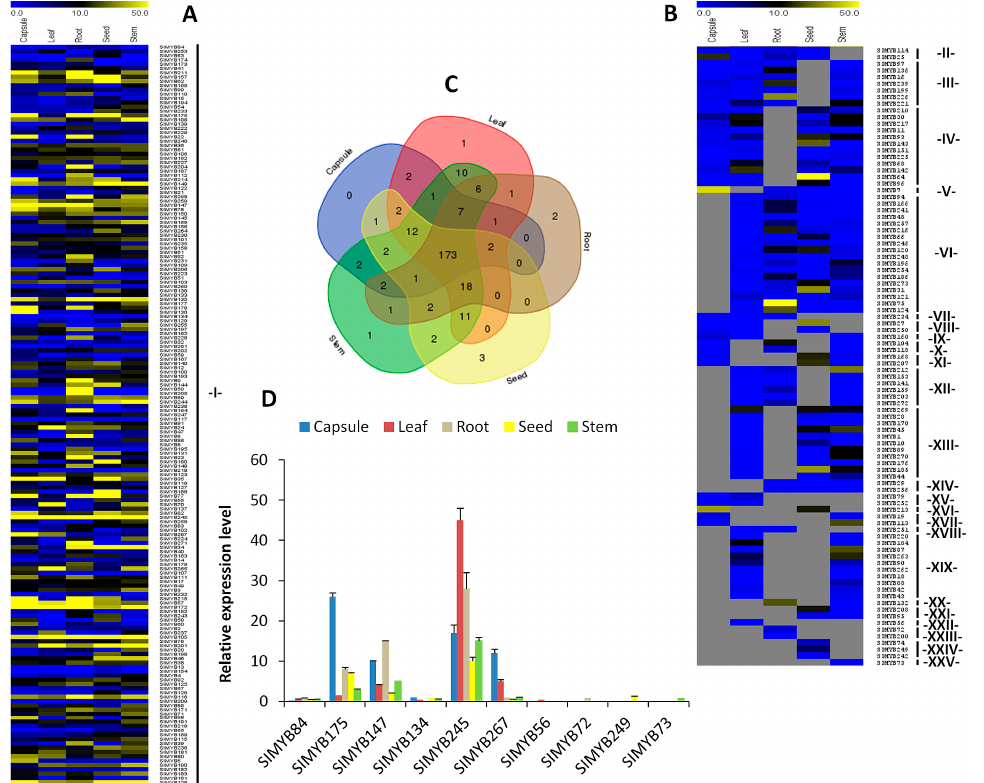
Figure 4. Expression profile analysis of MYB genes in five sesame tissues. The SIMYB genes expressed (RPKM > 1) in leaf, stem, root, seed and capsule were represented according to their tissue specificity: ( A ) SIMYB s commonly expressed in the five tissues; ( B ) SIMYBs expressed in only some tissues; ( C ) Venn diagram exhibiting the numbers of common and unique SIMYB genes expressed in the various sesame tissues; and, ( D ) Validation through qRT-PCR of the expression patterns of ten selected genes. Gray cells represent genes not expressed. -I- to -XXV- represent the groups of genes according to their tissue specificity (Table S4).